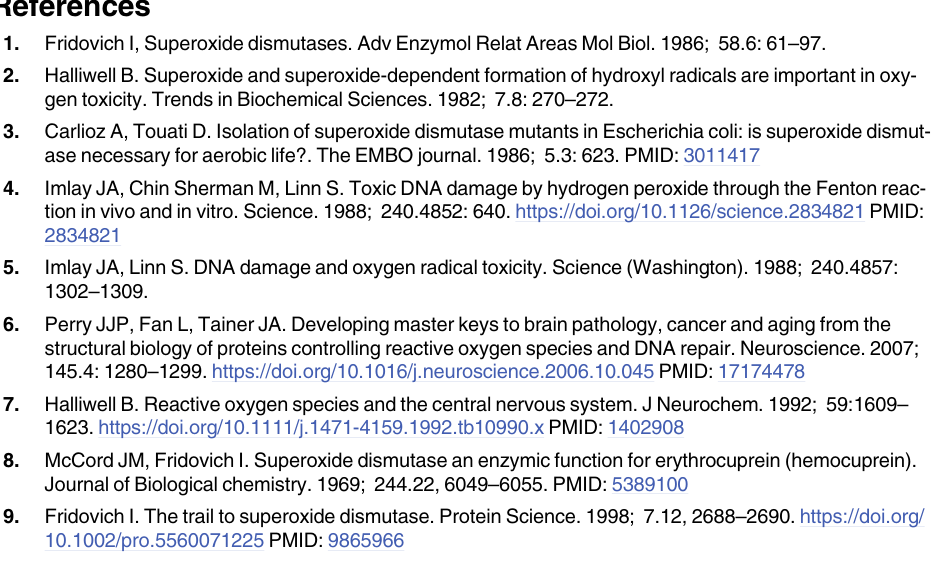
S4 Fig. Effect of a temperature increase on the frequency spectral content of the total dipole moment. Effect of a 35K temperature increase on the frequency spectral content of the dipole moment (y-component) of all chemical species inside the simulation box (first column), the Cu,ZnSOD1 alone (second column) and the water molecules (third column).